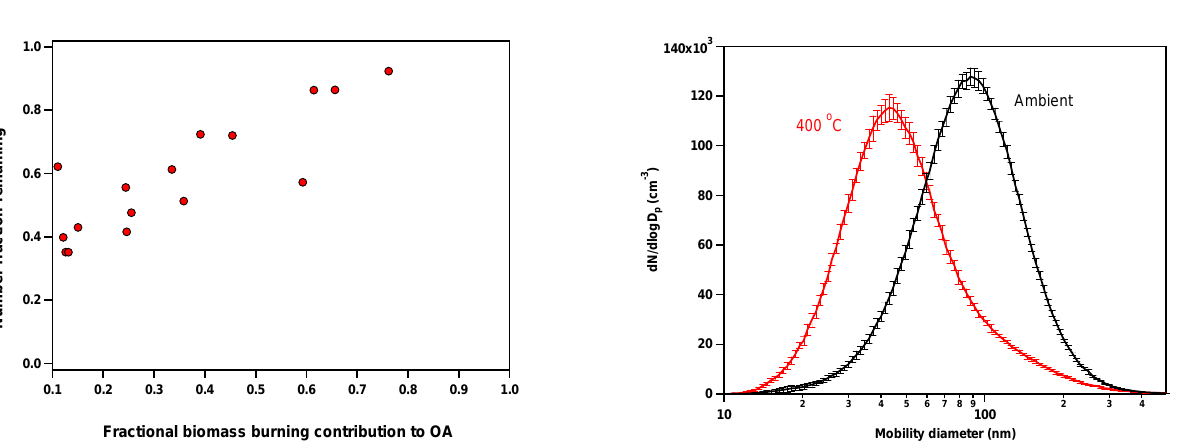
Figure 6. Average particle number size distribution (17 scans; 3min time span) for a major biomass burning period (BBOA was around 75% of the OA) at ambient conditions (black) and 400 ◦ C corrected for losses (red). Vertical lines correspond to confidence